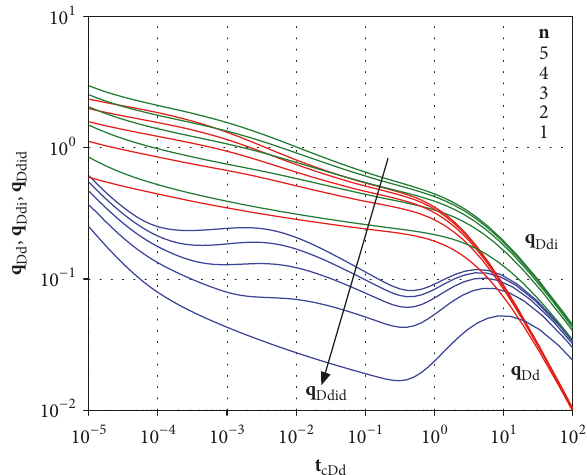
Figure 7: The effect of spacing between adjacent horizontal sections on type